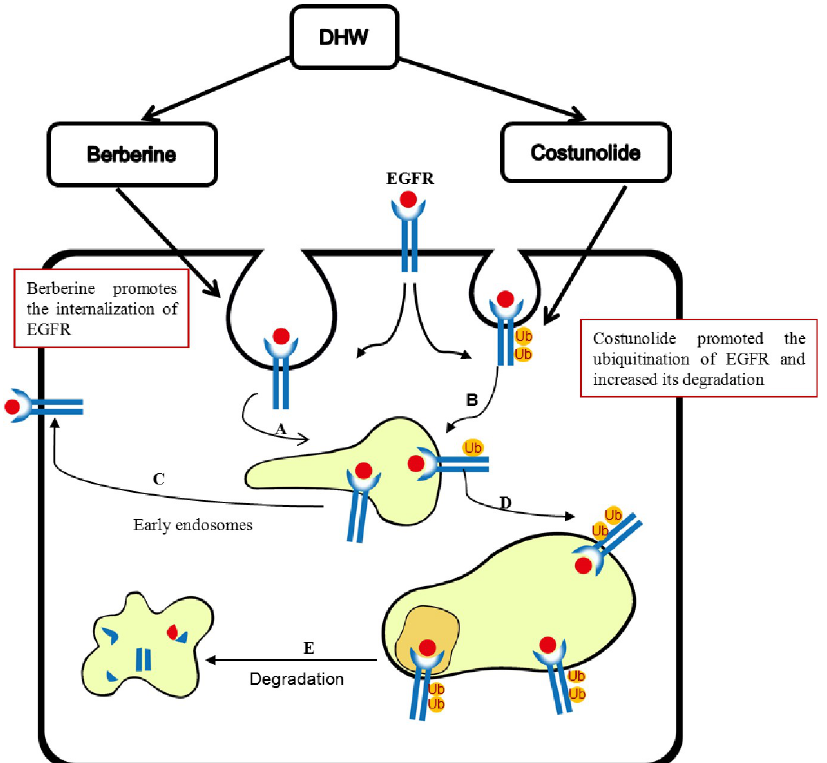
Fig 5. A model for the function of DHW in EGFR homeostasis. Berberine and Costunolide are the main active ingredients in DHW. Berberine promotes endocytosis of activated EGFR, while as Costunolide increases ubiquitination of EGFR and reduces EGFR recycling to cell membrane distribution, thereby inhibiting EGF signaling. Part of internalized EGFR goes into early endosomes (A). Following their internalization into early endosomes, nonubiquitinated receptors are recycled back to the plasma membrane (C). Part of internalized EGFR is ubiquitinated (B). Ubiquitinated EGFRs proceed toward the multivesicular bodies (D). Ubiquitinated cargo pour into lysosomes for degradation